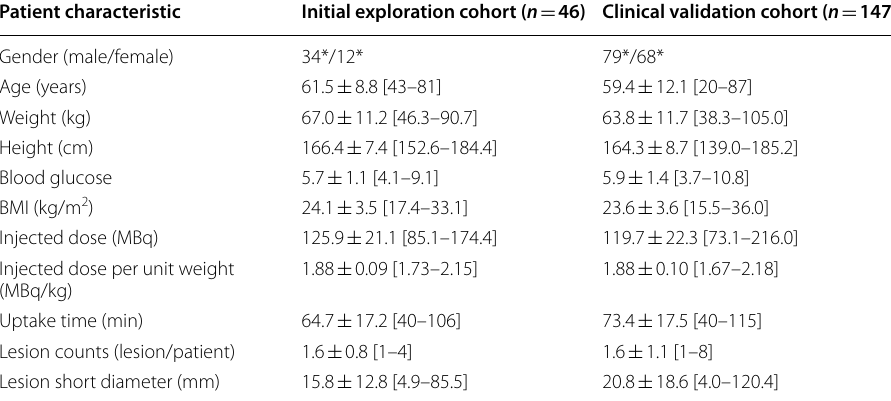
Unless otherwise specified, data are presented as mean *Data are numbers of patients. BMI